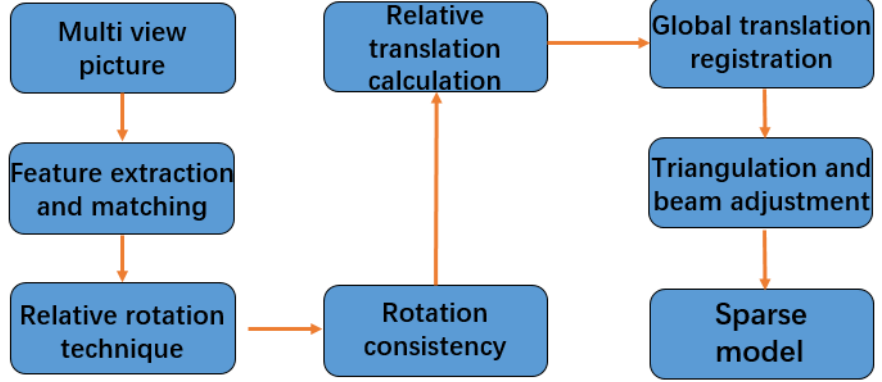
Figure 2. The flow chart of a global SFM algorithm.